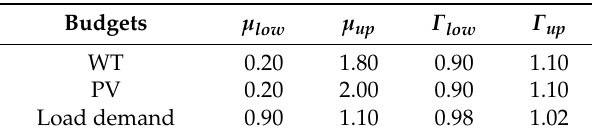
Table 3. Uncertainty set